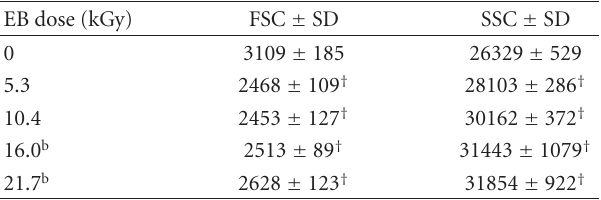
Table 3: Forward-angle scatter (FSC) and side-angle scatter (SSC) values of EB-irradiated Bacillus spores.